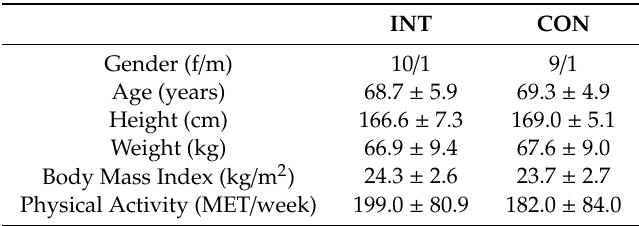
Table 1. Participants’ data for intervention (INT) and control (CON) groups. Data provided as means ± standard deviations